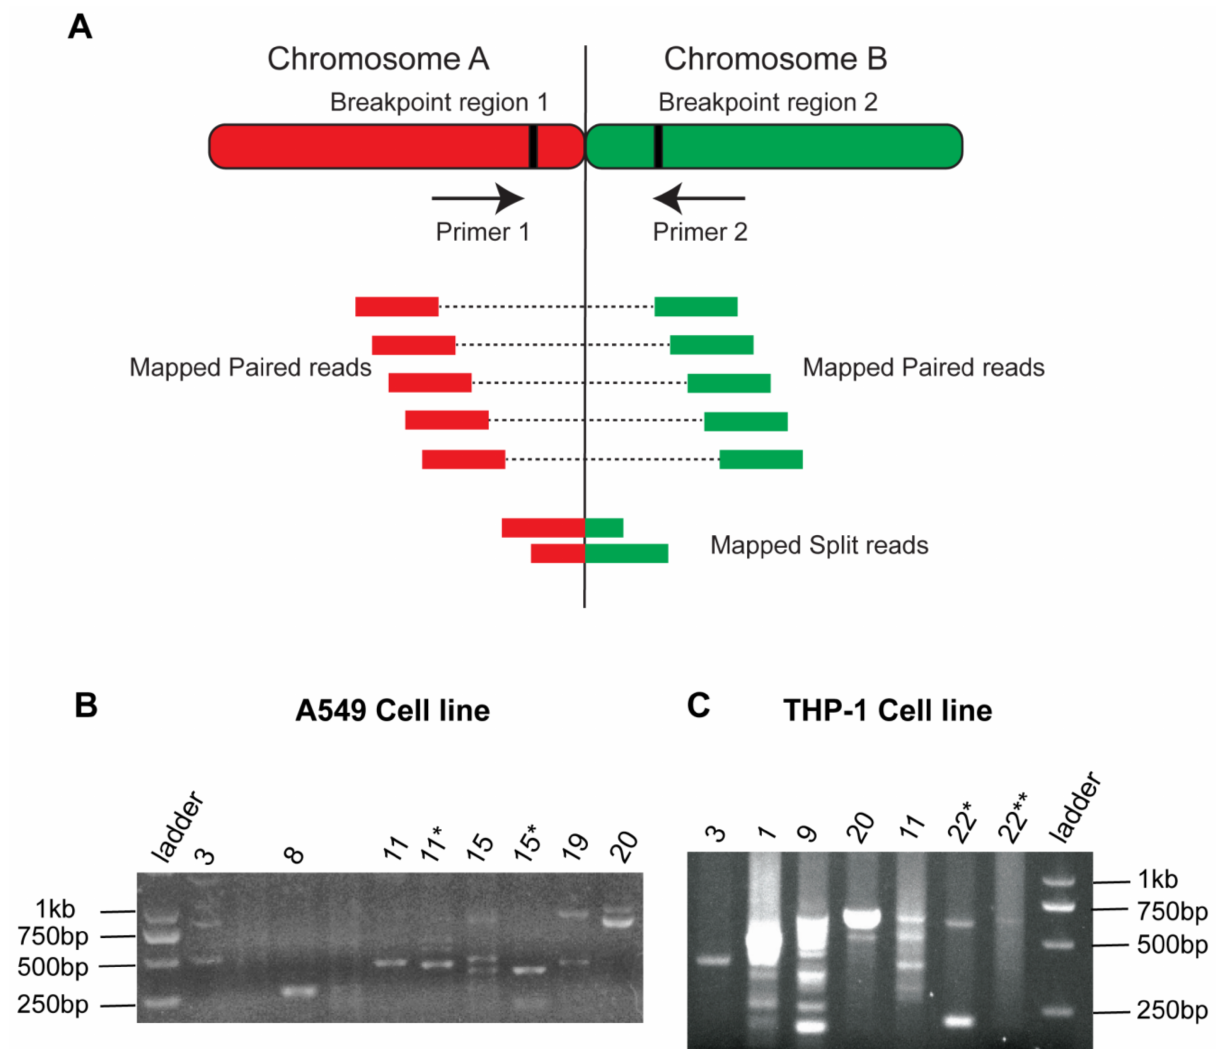
Figure 6. PCR Amplifications of translocated regions. ( A ) Illustration of primer design in the PCR validations method. ( B ) PCR validation results in A549 cell line ( C ) PCR validation results in THP-1 cell line. Gel bands represent the translocated reads of different sizes that appeared because of chromosomal translocations. * and ** indicate first and second replicates,